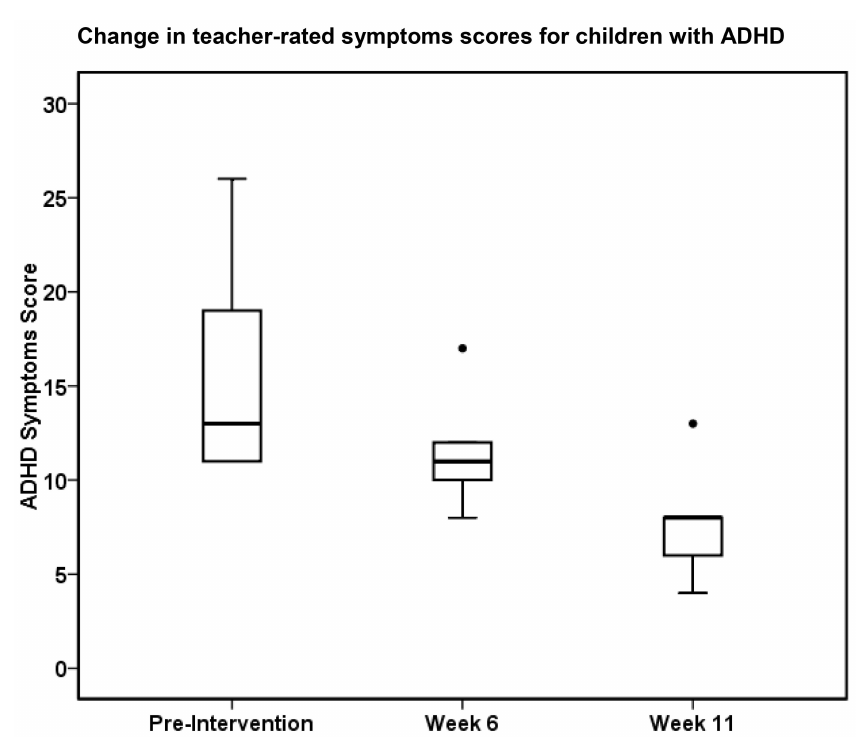
Figure 1. The graph shows a statistically significant reduction in teacher-rated symptom scores (median and range) for the children with ADHD ( n = 6) after 11 weeks of exercise; p =